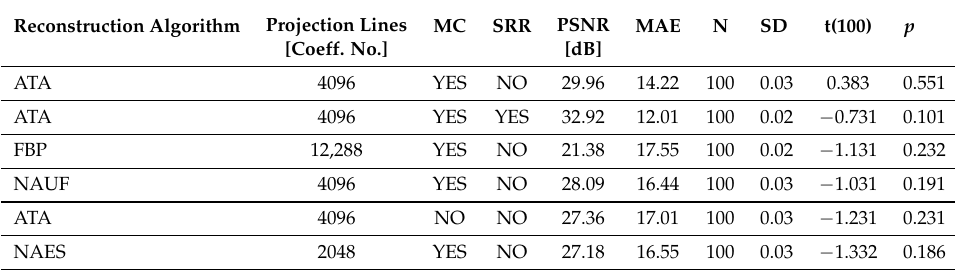
Table 2. The performance of different reconstruction algorithms for Zubal phantom. Reconstruction Algorithm Projection Lines [Coeff. No.]